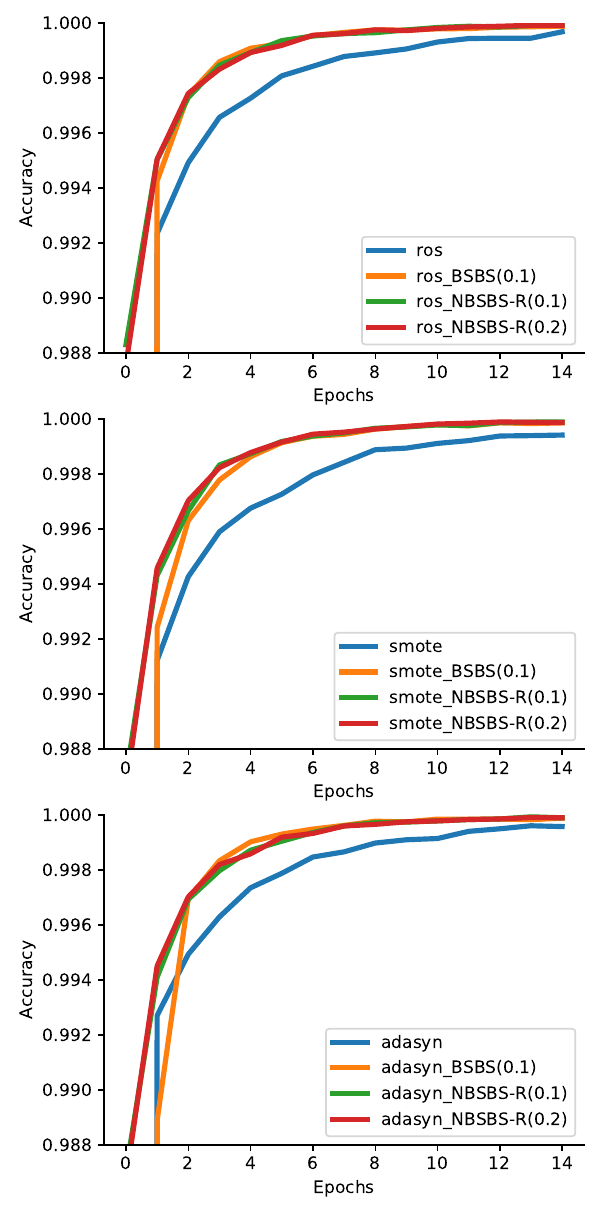
Figure 2. The training curves of the models for three different data-transformation methods (ROS at the top , SMOTE at the middle , Adasyn at the bottom ). Table 9. F1-score comparison on the generalization with other online sampling methods.